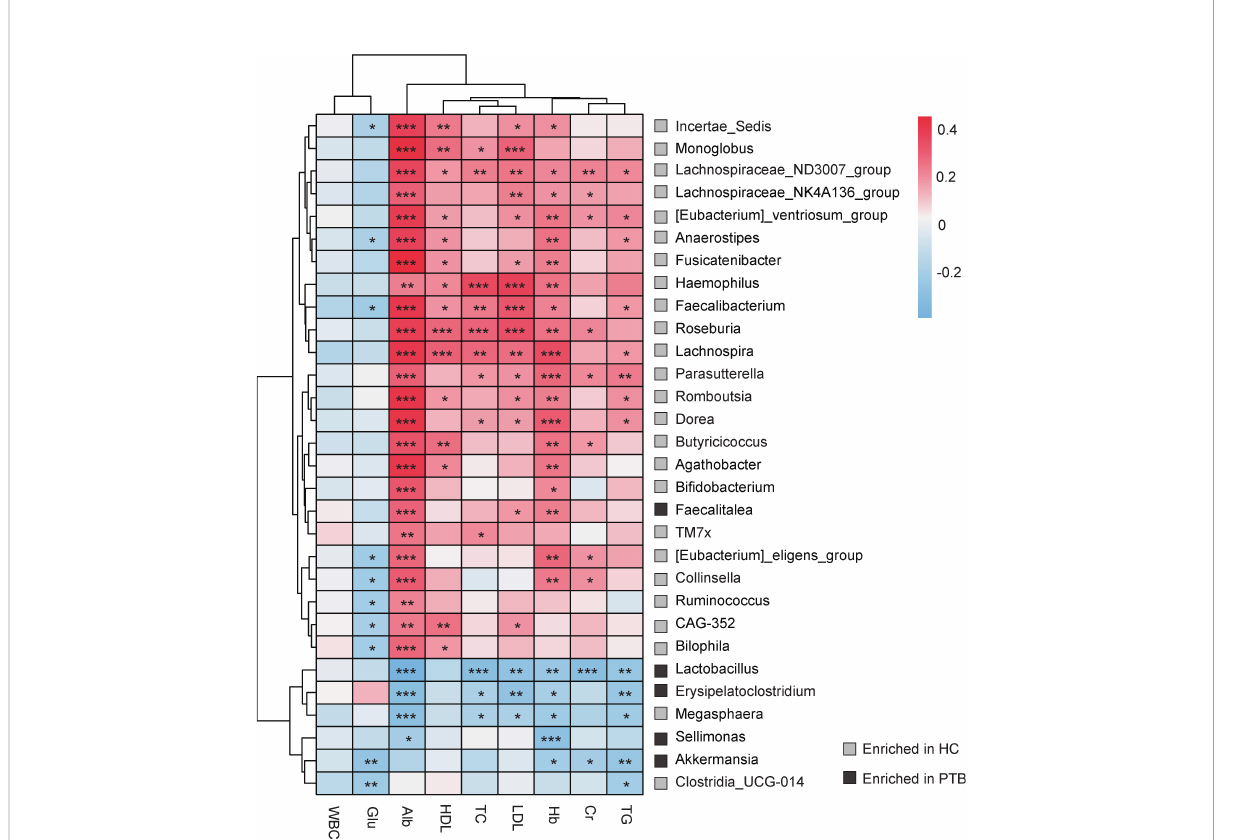
FIGURE 3 Correlation analysis between intestinal fl ora and biochemical indexes. The depth of the color in the heat maps signi fi es the strength of the correlation: red represents a positive correlation, whereas blue indicates a negative correlation. * P <0.05, ** P <0.01, *** P <0.001. The correlation were assessed by the Spearman test. Grey represents features enriched in HCs, while black represents features enriched in PTB